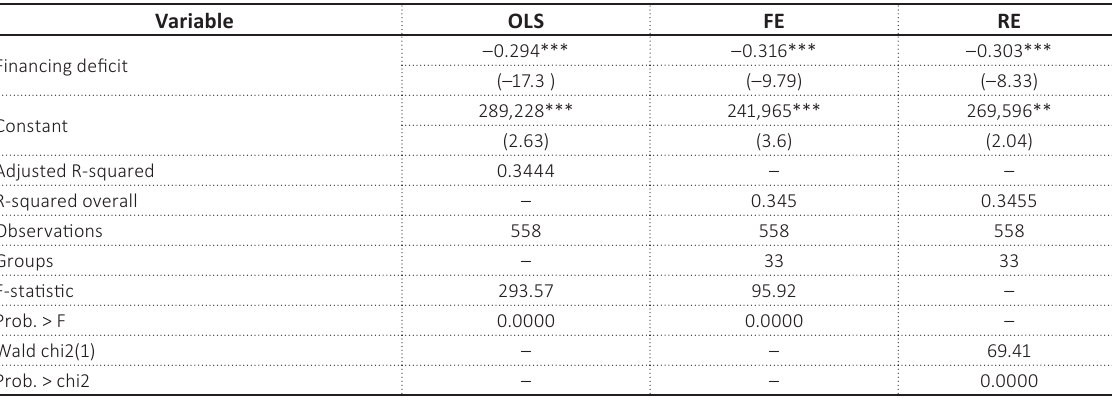
Table 3. Regression results: Pecking order